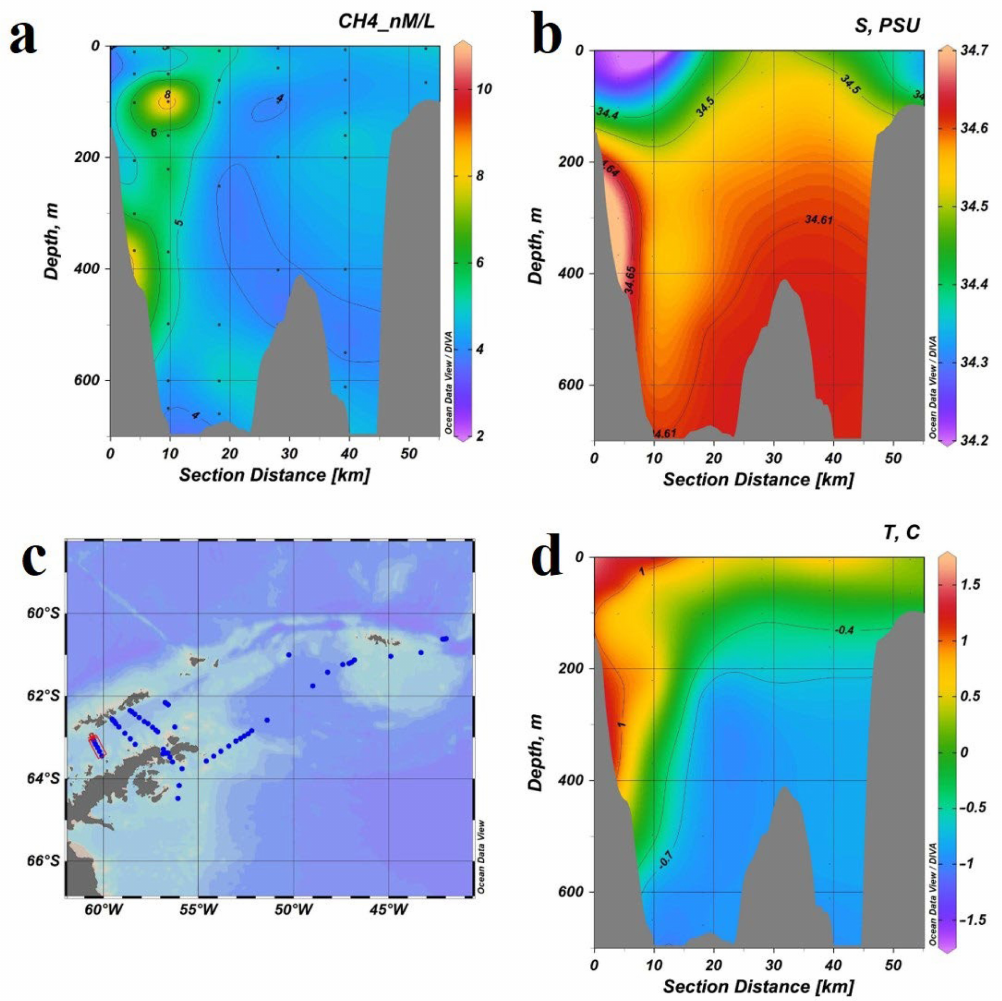
Figure 2. Distribution of methane concentration ( a ), temperature ( d ) and salinity ( b ) in the western section ( c ) in the Bransfield